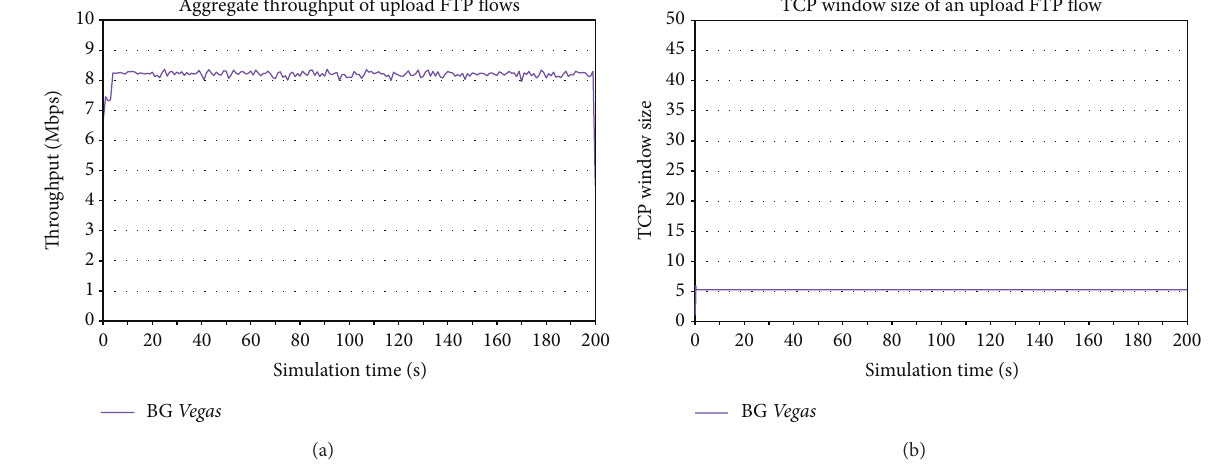
Figure 10: Competition of MMORPG and FTP background traffic using TCP Vegas : (a) aggregate throughput of the 10 FTP flows and (b) evolution of the TCP window of one of the flows.